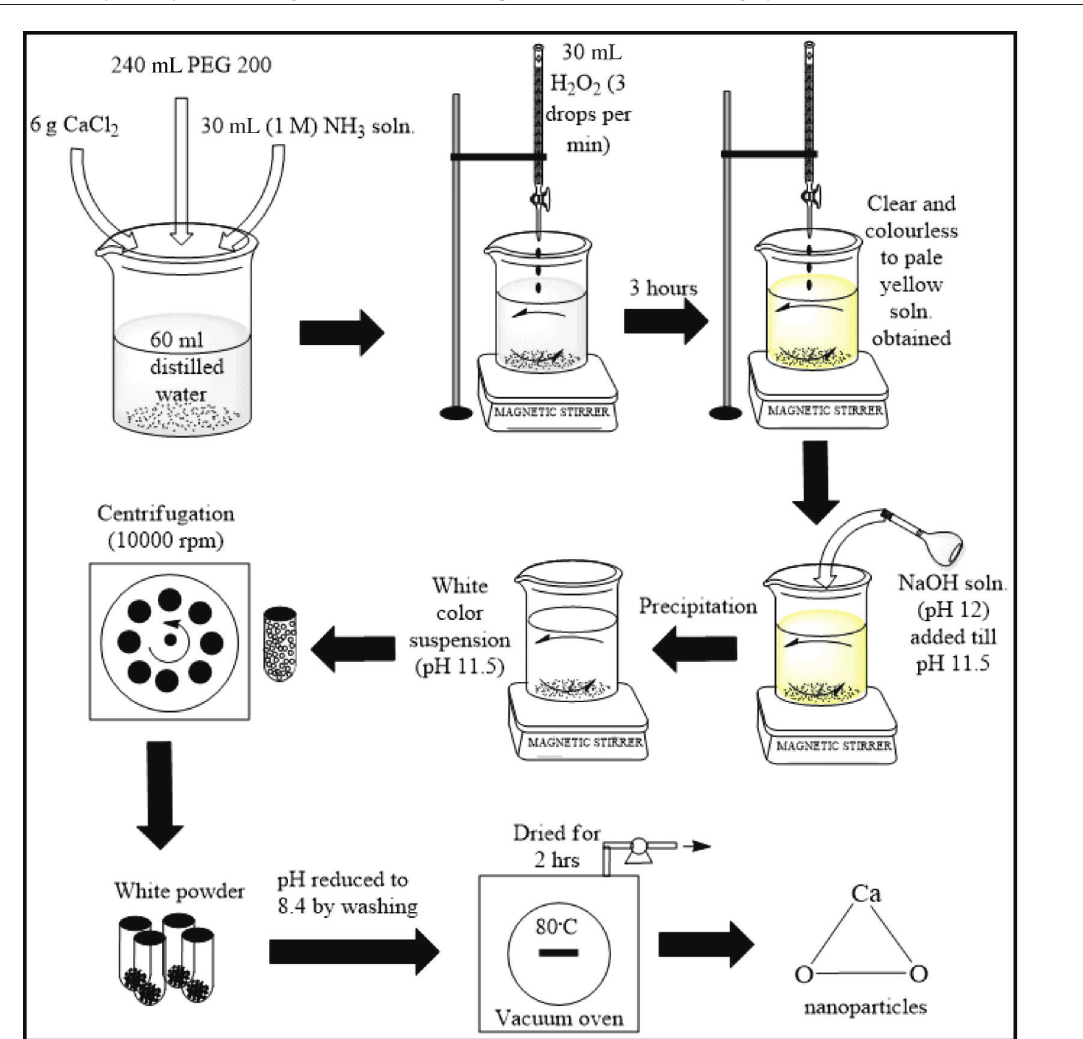
Fig. 1 – Schematic representation of the synthesis of CaO